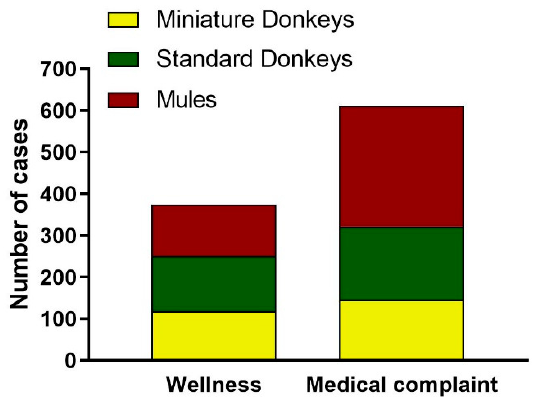
Figure 8. Distribution of Reason of the Visit for Donkey and Mule Caseload from 2008 to 2017. The distribution of donkey and mule visits divided into visit categories: Wellness Visits and Medical Complaint Visits. Standard donkeys (green), miniature donkeys (yellow), and mules (red).